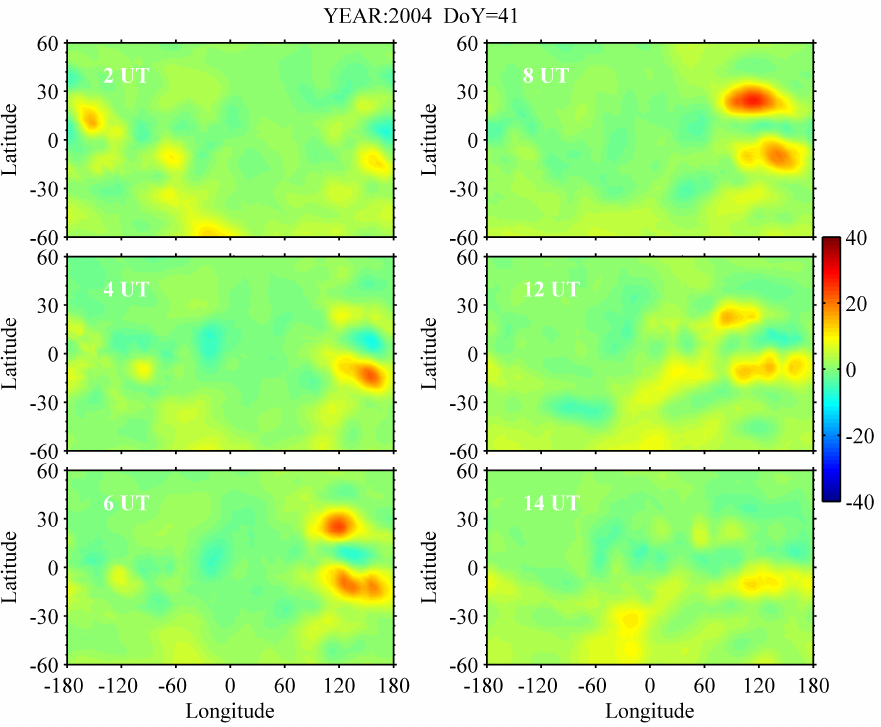
Fig. 2. The deviations ( 1 TEC) from the median values of JPL GIM total electron content (TEC) as a function of longitude and latitude at six universal times on 10 February (day 41), 2004. The median values are evaluated from the 31-day observations centered on 10 February